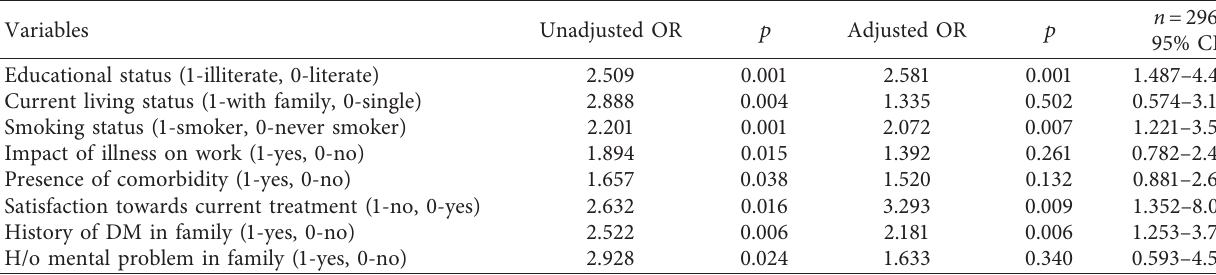
Table 7: Factors associated with the depression of